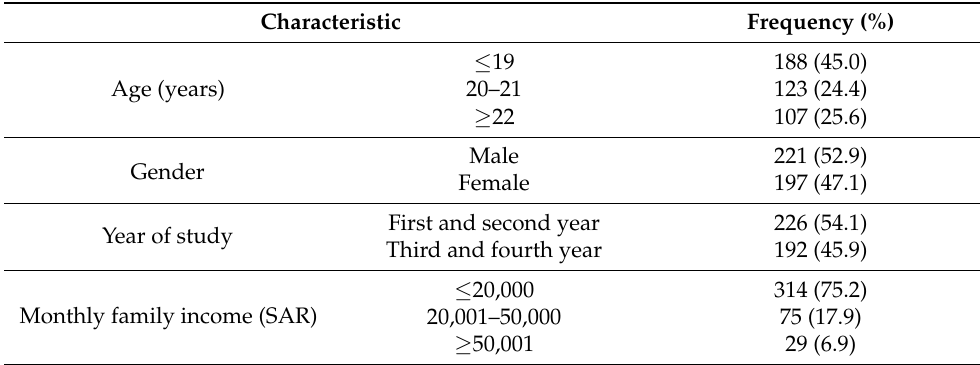
Table 1. Demographic characteristics of the participants ( n = 418).